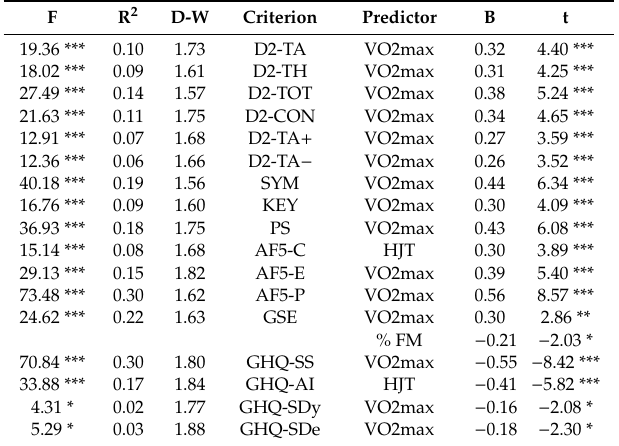
Table 6. Linear regression analysis of D2 test factors, processing speed, self-concept (AF5), general steps). F R